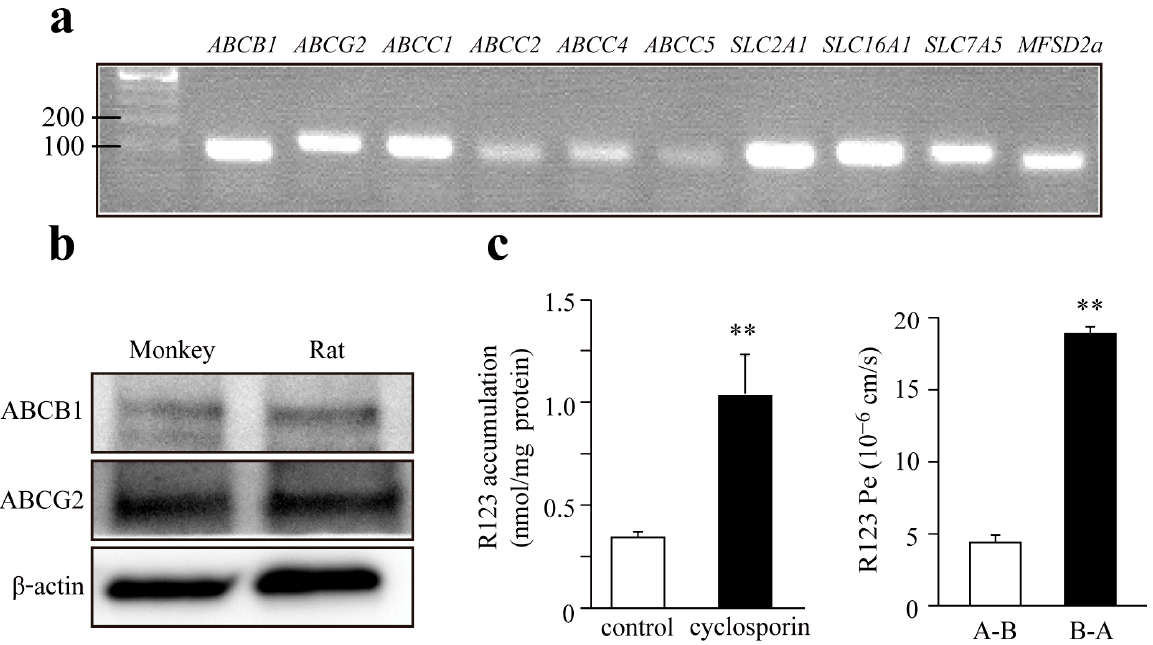
Figure 2. ( a ) Expression of transporters on monkey brain endothelial cells using PCR analysis; ( b ) Expression of efflux transporters ABCB1 and ABCG2 detected by western blot; ( c ) Functional analysis of ABCB1 using rhodamine 123 (R123) accumulation assay ( left ) and bi-directional transport of R123 ( right ). Accumulation of R123 was increased by ABCB1 inhibitor (cyclosporin; 10 µ M). Transport of R123 in the basolateral to apical (B-A) was greater than apical to basolateral (A-B). Values presented are means ± SEM (n = 3–4, ** p < 0.01).